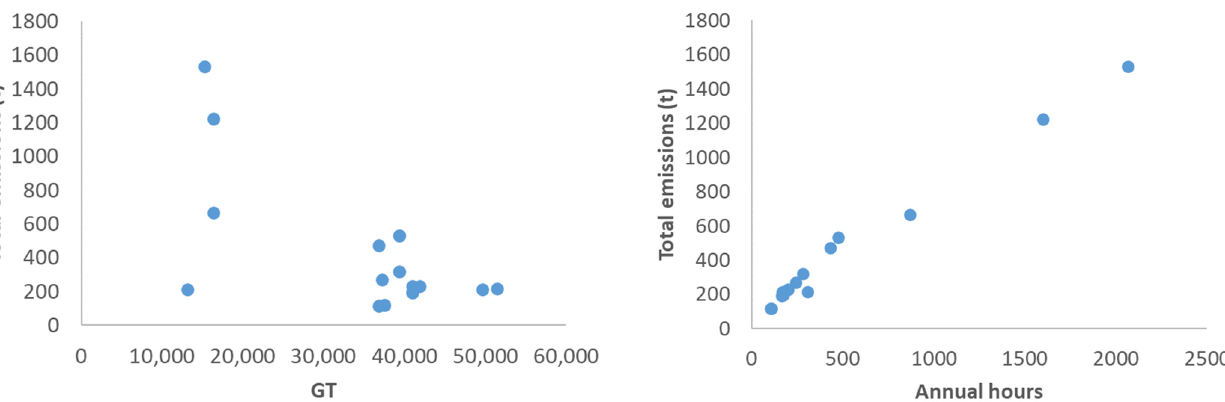
Table 15. Regression curves in the total emissions